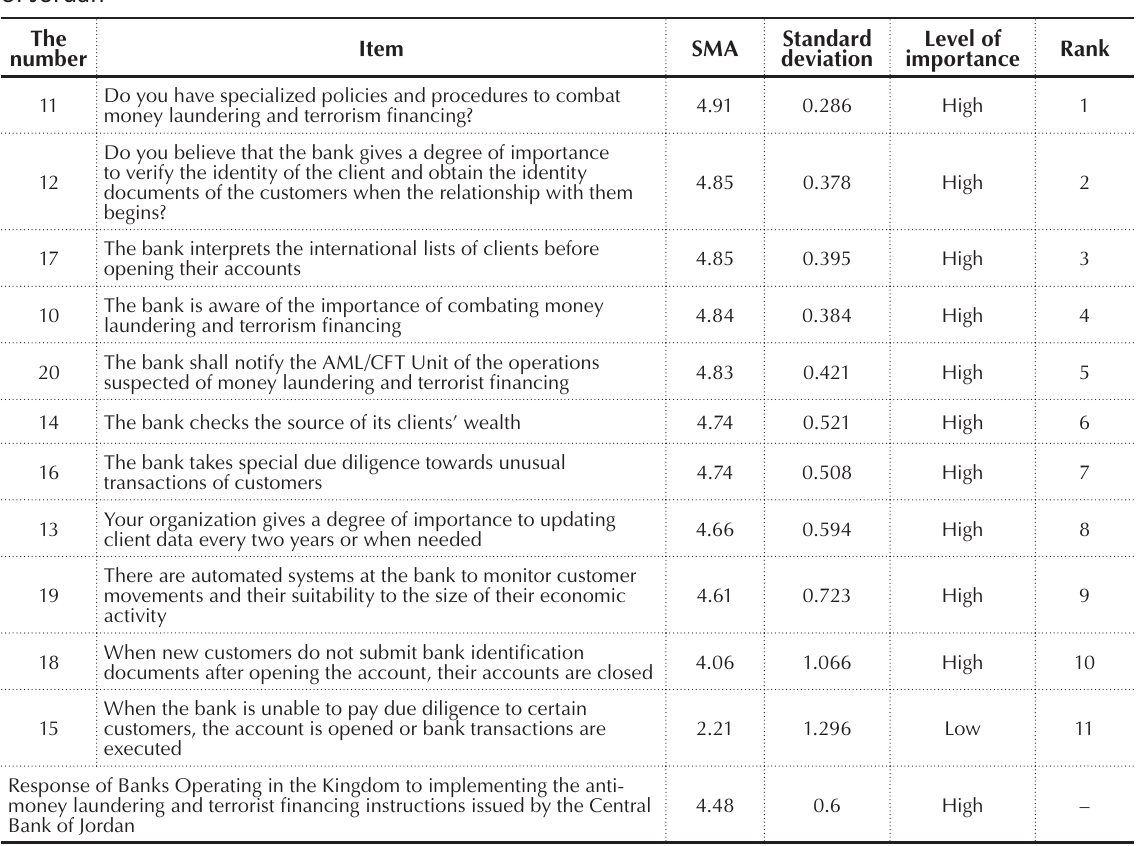
Table 4. (cid:47)(cid:374)(cid:282)(cid:349)(cid:272)(cid:258)(cid:410)(cid:381)(cid:396)(cid:400)(cid:3)(cid:373)(cid:286)(cid:258)(cid:400)(cid:437)(cid:396)(cid:349)(cid:374)(cid:336)(cid:3)(cid:410)(cid:346)(cid:286)(cid:3)(cid:271)(cid:258)(cid:374)(cid:364)(cid:400)(cid:859)(cid:3)(cid:396)(cid:286)(cid:400)(cid:393)(cid:381)(cid:374)(cid:400)(cid:286)(cid:400)(cid:3)(cid:410)(cid:381)(cid:3)(cid:410)(cid:346)(cid:286)(cid:3)(cid:349)(cid:374)(cid:400)(cid:410)(cid:396)(cid:437)(cid:272)(cid:415)(cid:381)(cid:374)(cid:400)(cid:3)(cid:400)(cid:286)(cid:410)(cid:3)(cid:271)(cid:455)(cid:3)(cid:410)(cid:346)(cid:286)(cid:3)(cid:18)(cid:286)(cid:374)(cid:410)(cid:396)(cid:258)(cid:367)(cid:3)(cid:17)(cid:258)(cid:374)(cid:364)(cid:3)(cid:3)